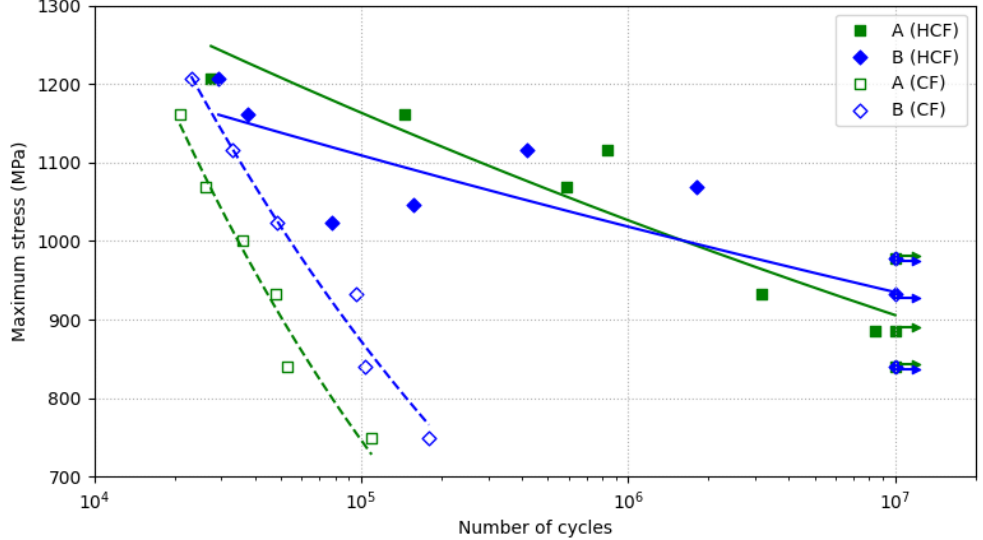
Figure 5. Wöhler diagrams obtained for the A-type and B-type H13 steels in the high-cycle fatigue domain under normal and corrosion fatigue conditions.